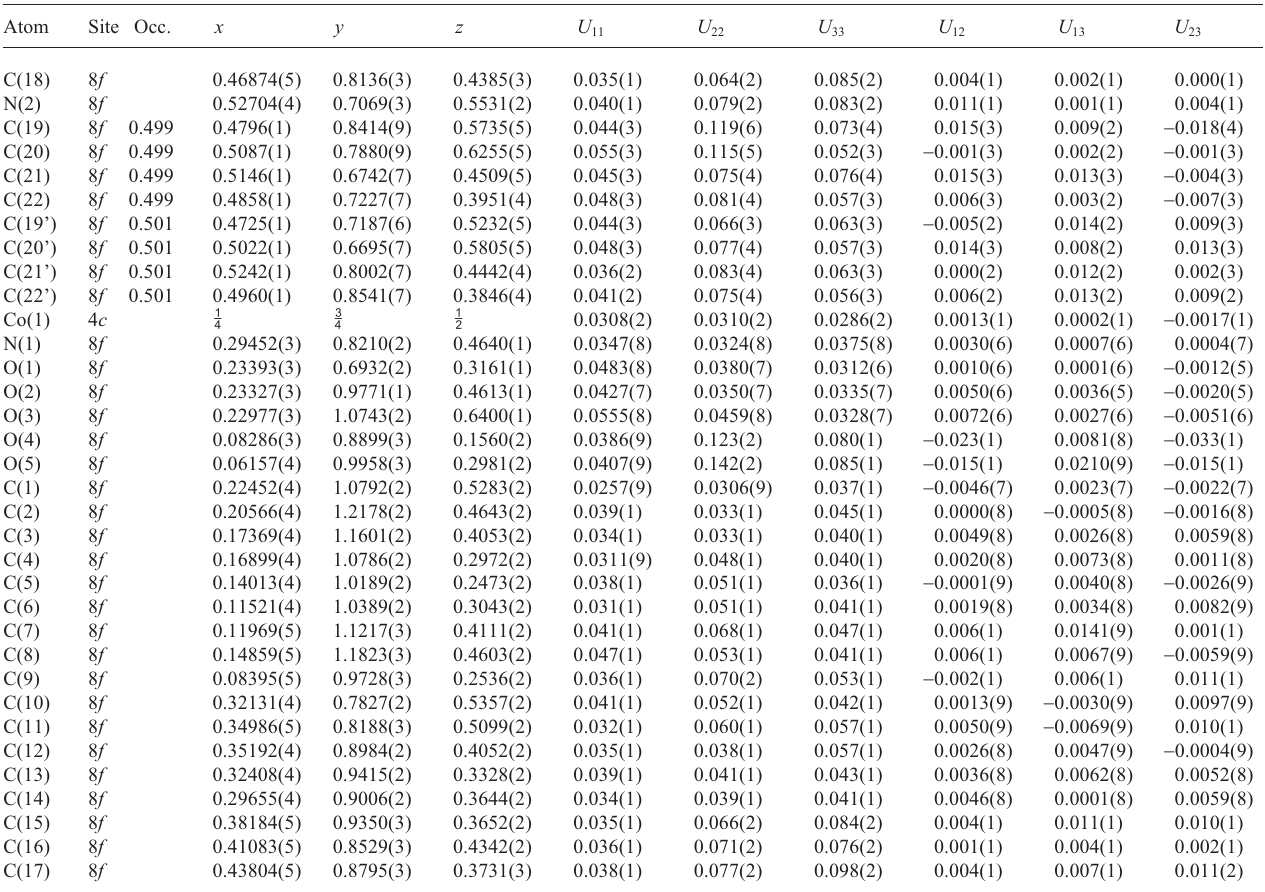
Table 3. Atomic coordinates and displacement parameters (in Å 2 )